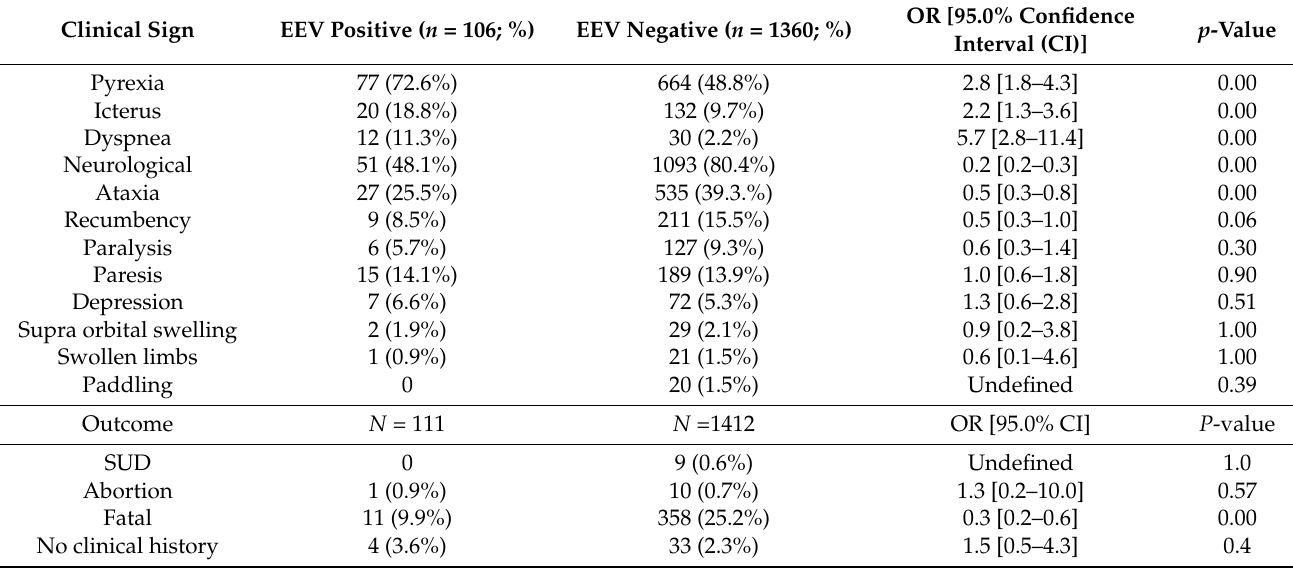
Table 1. Clinical signs reported in horses upon submission of samples to the Centre for Viral Zoonoses from 2010–2017. Clinical signs significantly associated with equine encephalosis virus-positive animals are indicated in bold. Excluded from the odds ratio (OR) calculations were animals with no clinical information ( n = 57).